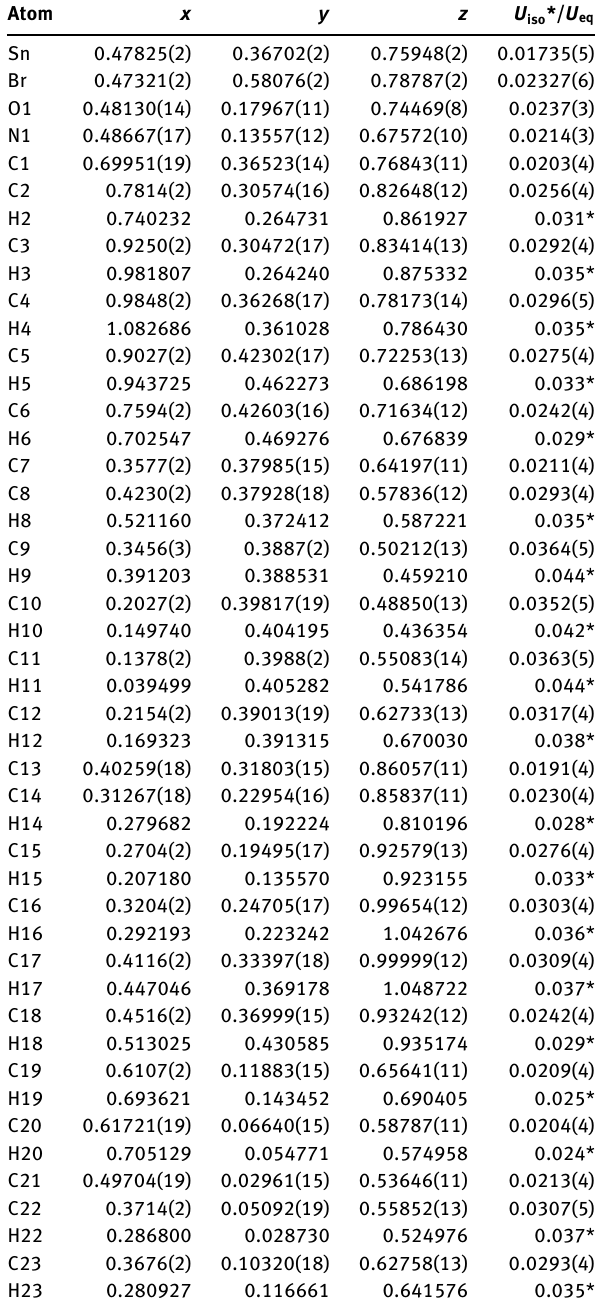
Table 2: Fractional atomic coordinates and isotropic or equivalent isotropic displacement parameters (Å 2